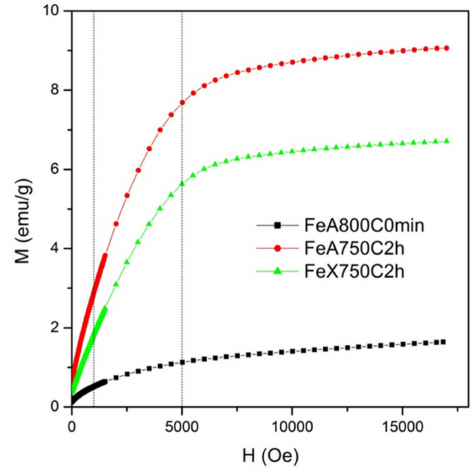
Figure 5. Room-temperature magnetization curves in the first quadrant for the three examined